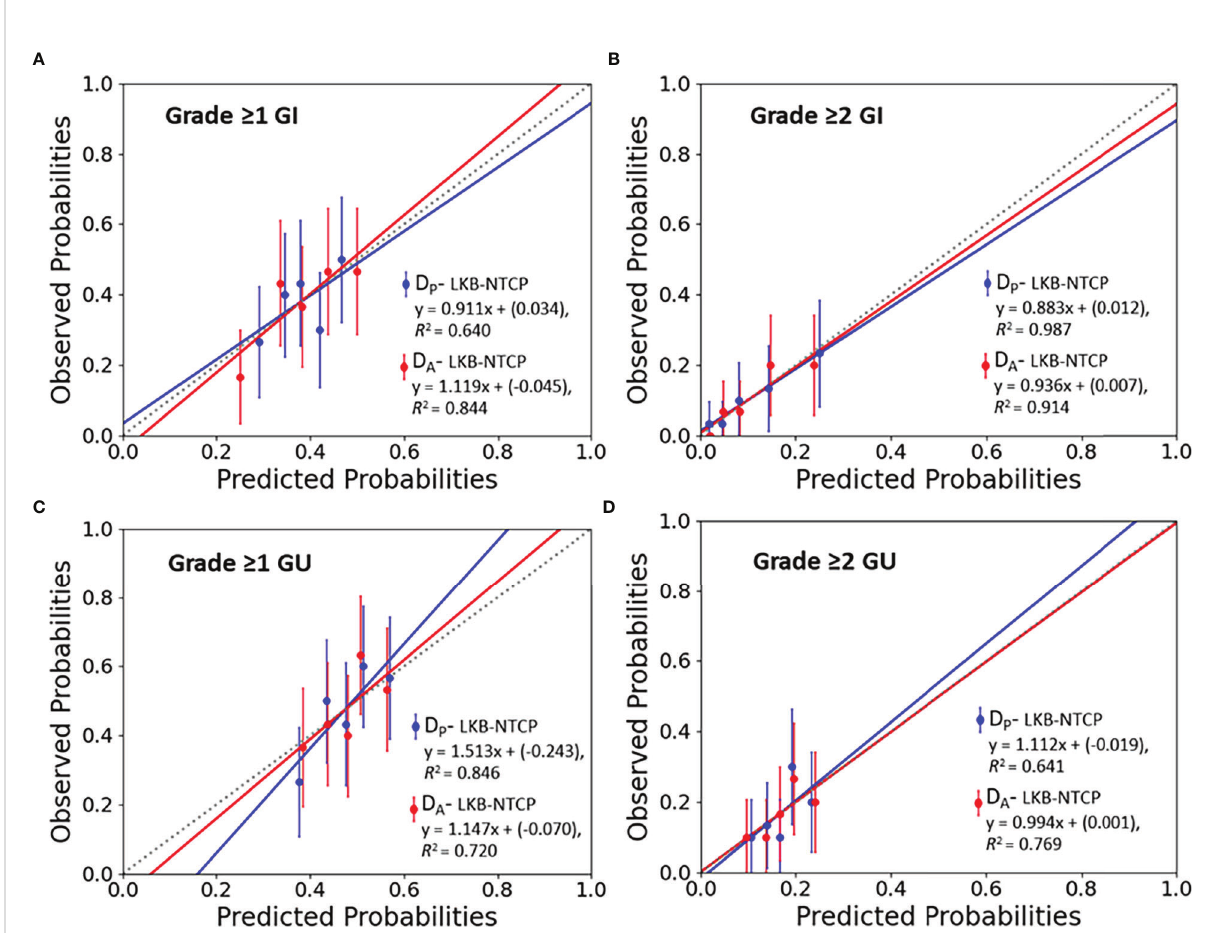
FIGURE 2 Calibration plots (predicted vs observed probabilities) for LKB-NTCP derived parameters with the associated late toxicity endpoints for (A) Grade ≥ 1 GI, (B) Grade ≥ 2 GI, (C) Grade ≥ 1 GU and (D) Grade ≥ 2 GU toxicity. The 45° dotted line represents the reference line